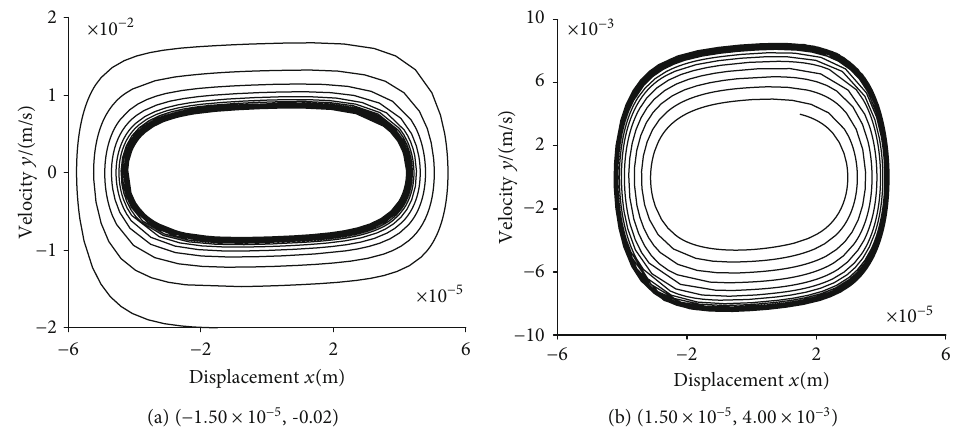
= 8 : 0 × 10 − 5 m , l = 2 : 0 × 10 − 5 m 0